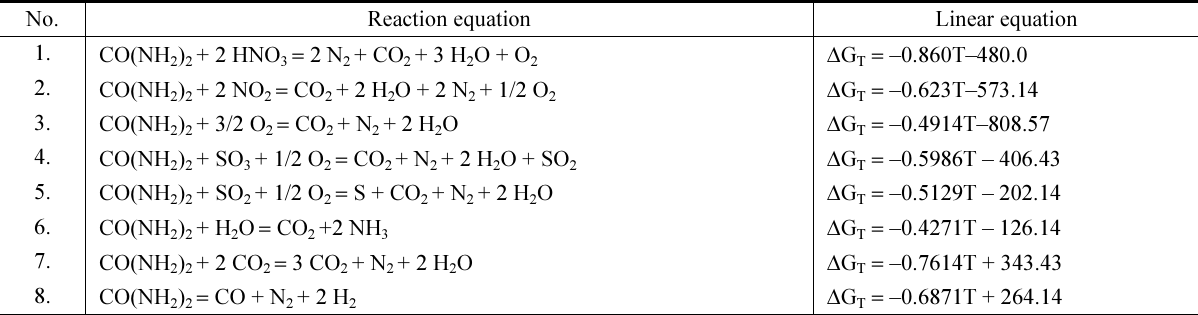
Table 2. The Gibbs’ energy change value dependency on temperature of main reactions between carbamide and other substances, present in the boiler-house flue gases No. Reaction equation Linear